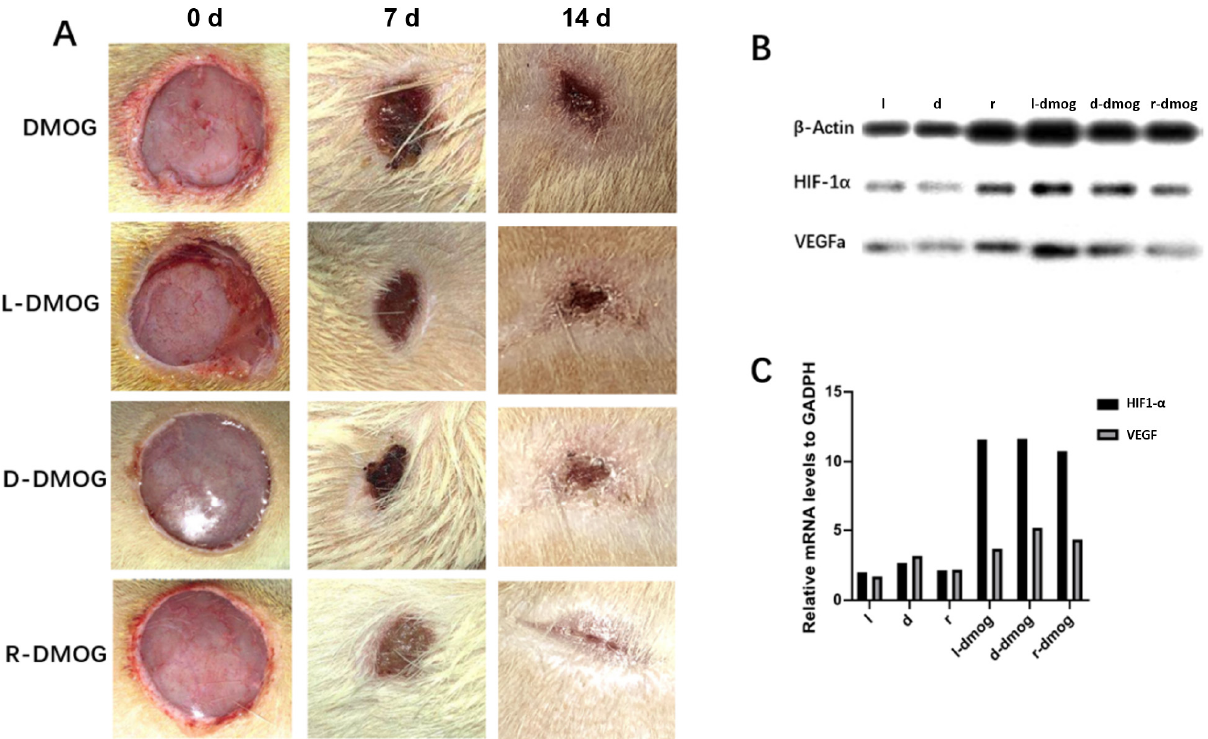
Figure 4. ( A ) Skin wound healing in diabetic rats. Compared with the pure DMOG drug, the use of the hydrogel compound drug can significantly promote the wound-healing rate of diabetic rats; ( B ) the protein was extracted from the wound of the rat, and it was found that the right-handed chiral hydrogel combined with the DMOG drug group could significantly promote the expression of HIF-1 α and VEGF in the tissue; ( C ) the extraction of mRNA from rat skin and qPCR showed that the hydrogel containing DMOG could significantly promote the content of HIF-1 α and VEGF in the tissue.